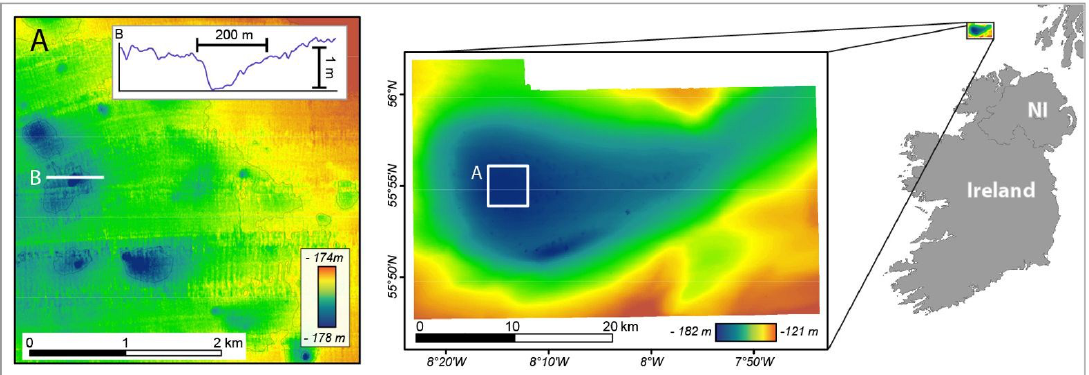
Figure 3. Location map of the Malin Deep dataset (Ireland) and bathymetric map obtained by INFOMAR. ( A ) Detailed view of the central area; ( B ) Bathymetric profile across of the pockmark indicated in ( A ).